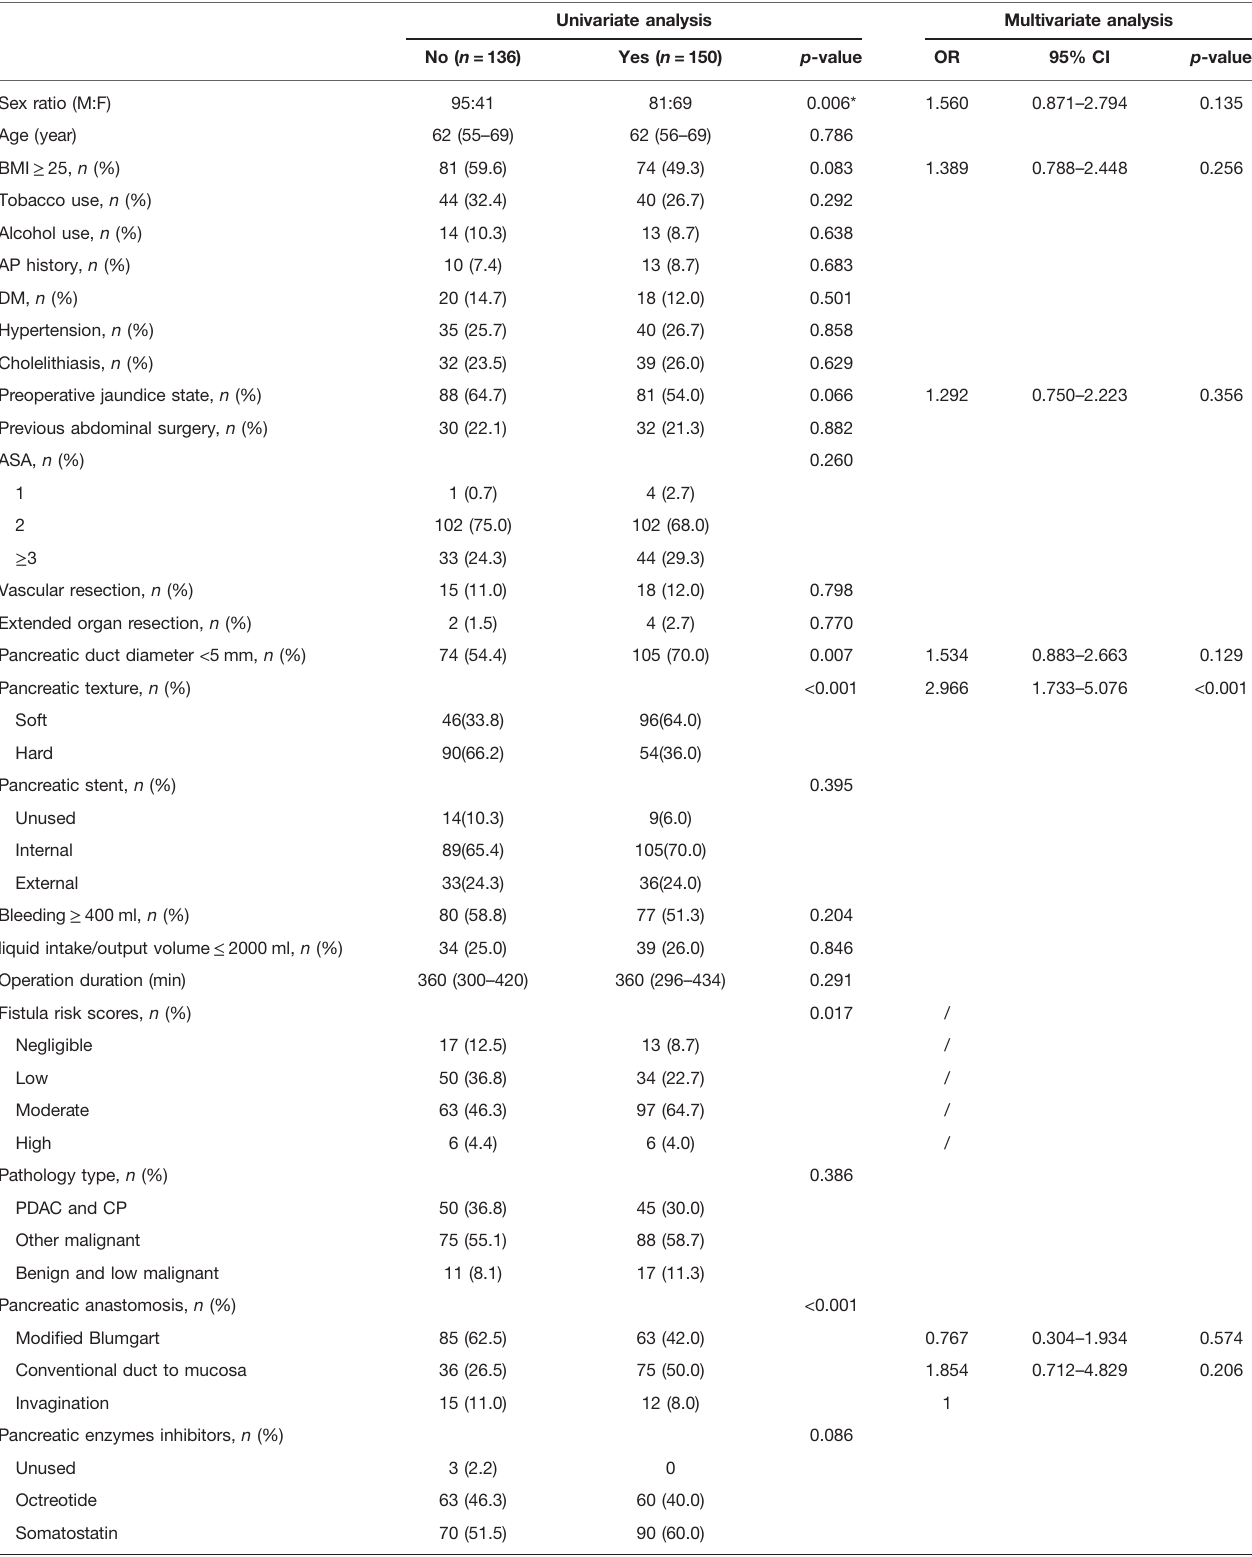
TABLE 3 | Univariate and multivariate analyses of PPAP.